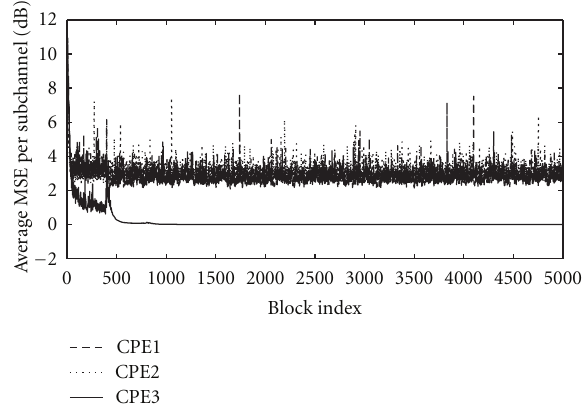
Figure 6: Stability performance comparison with 5 × 10 3 data blocks ( λ = 0 . 75 and 4-QAM).